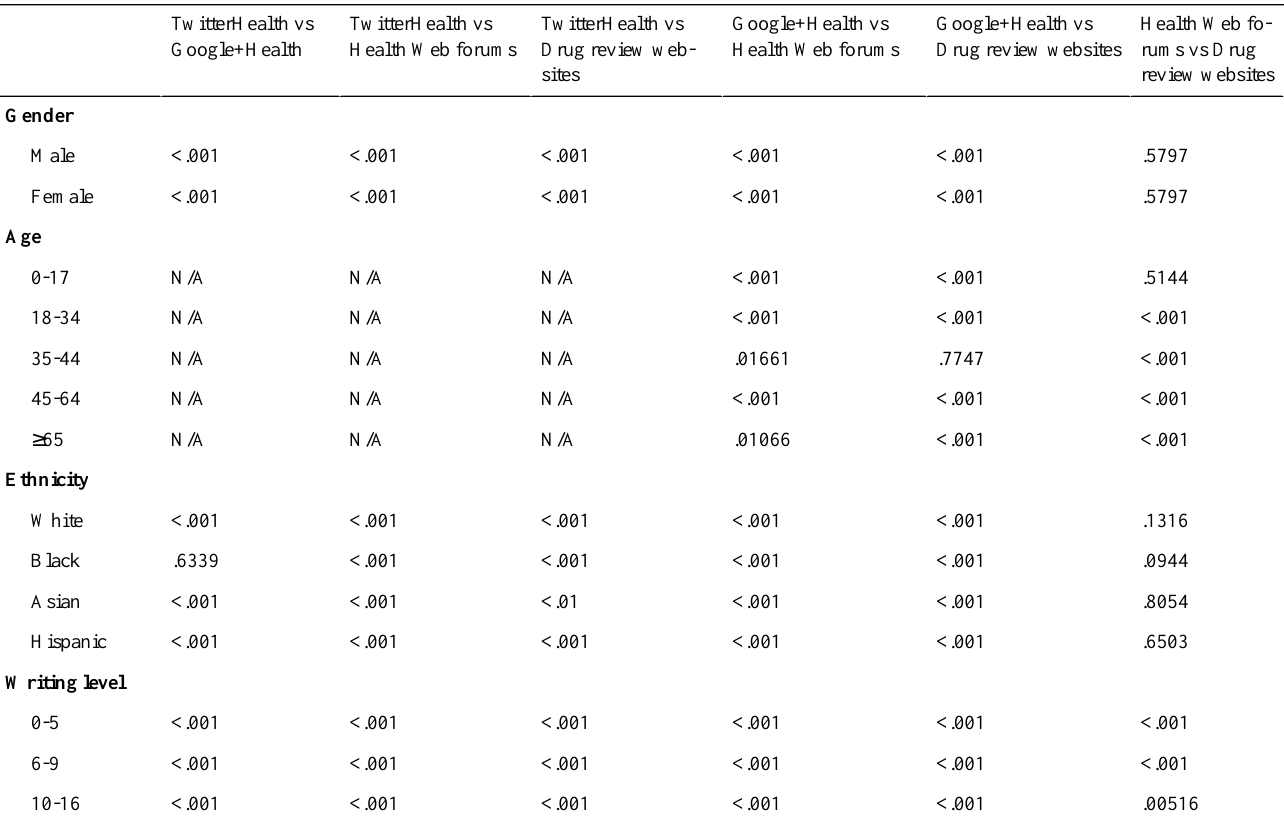
Table 9. P values for Mann-Whitney U